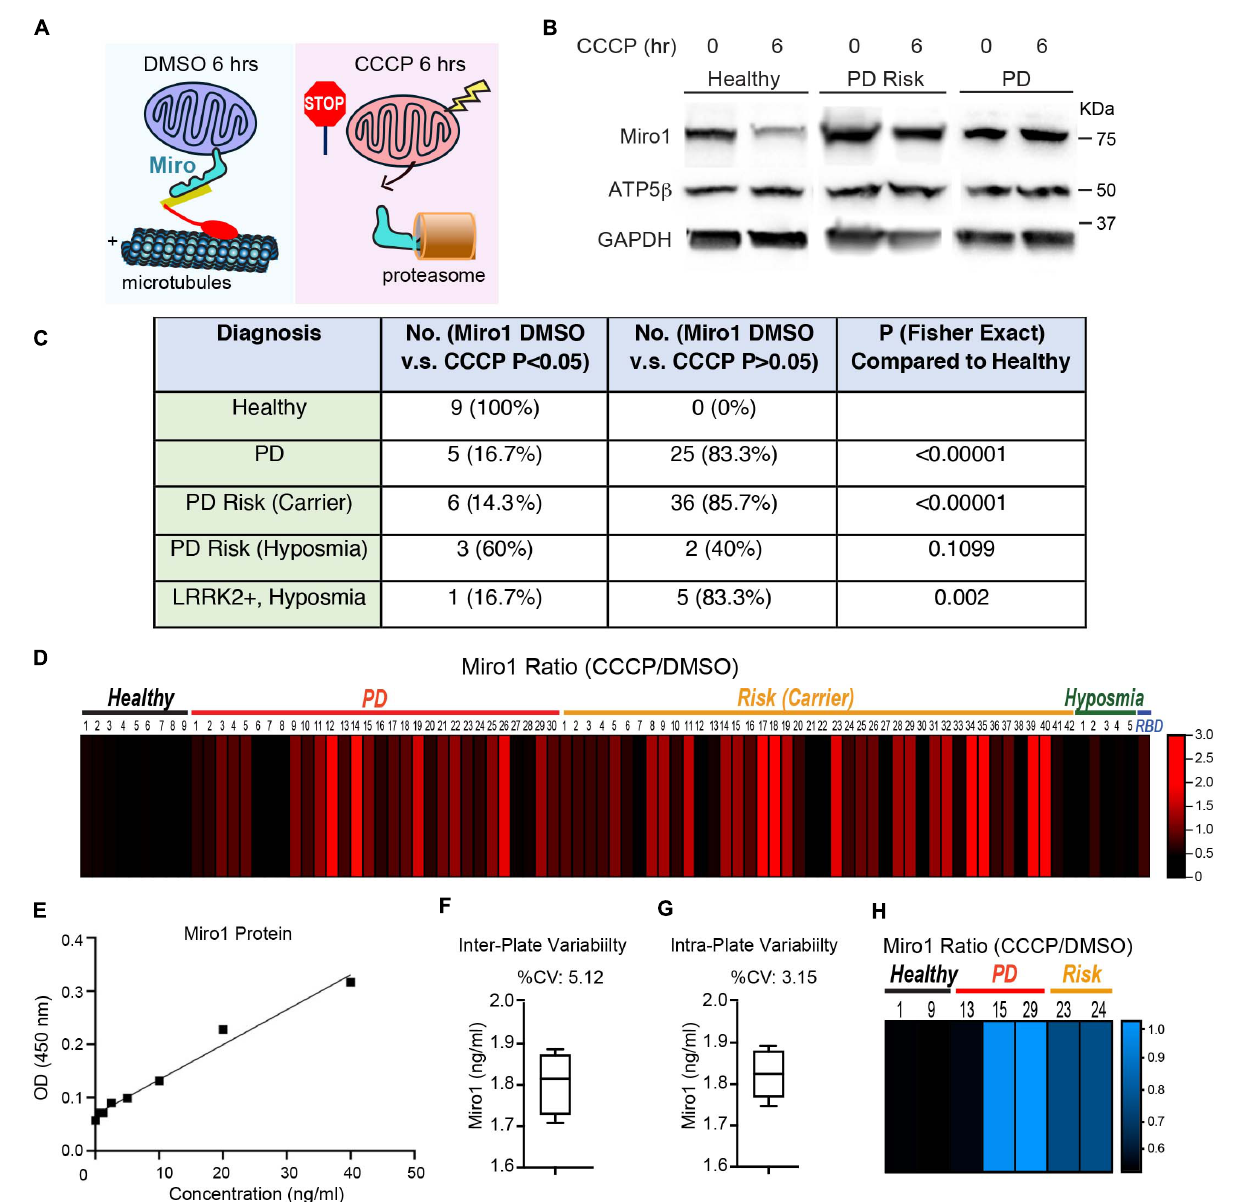
Status Examination, onset age), their interaction terms, and the intercept were generated. Out of all the partial regression plots for interaction terms, the plot of Hoehn and Yahr Scale